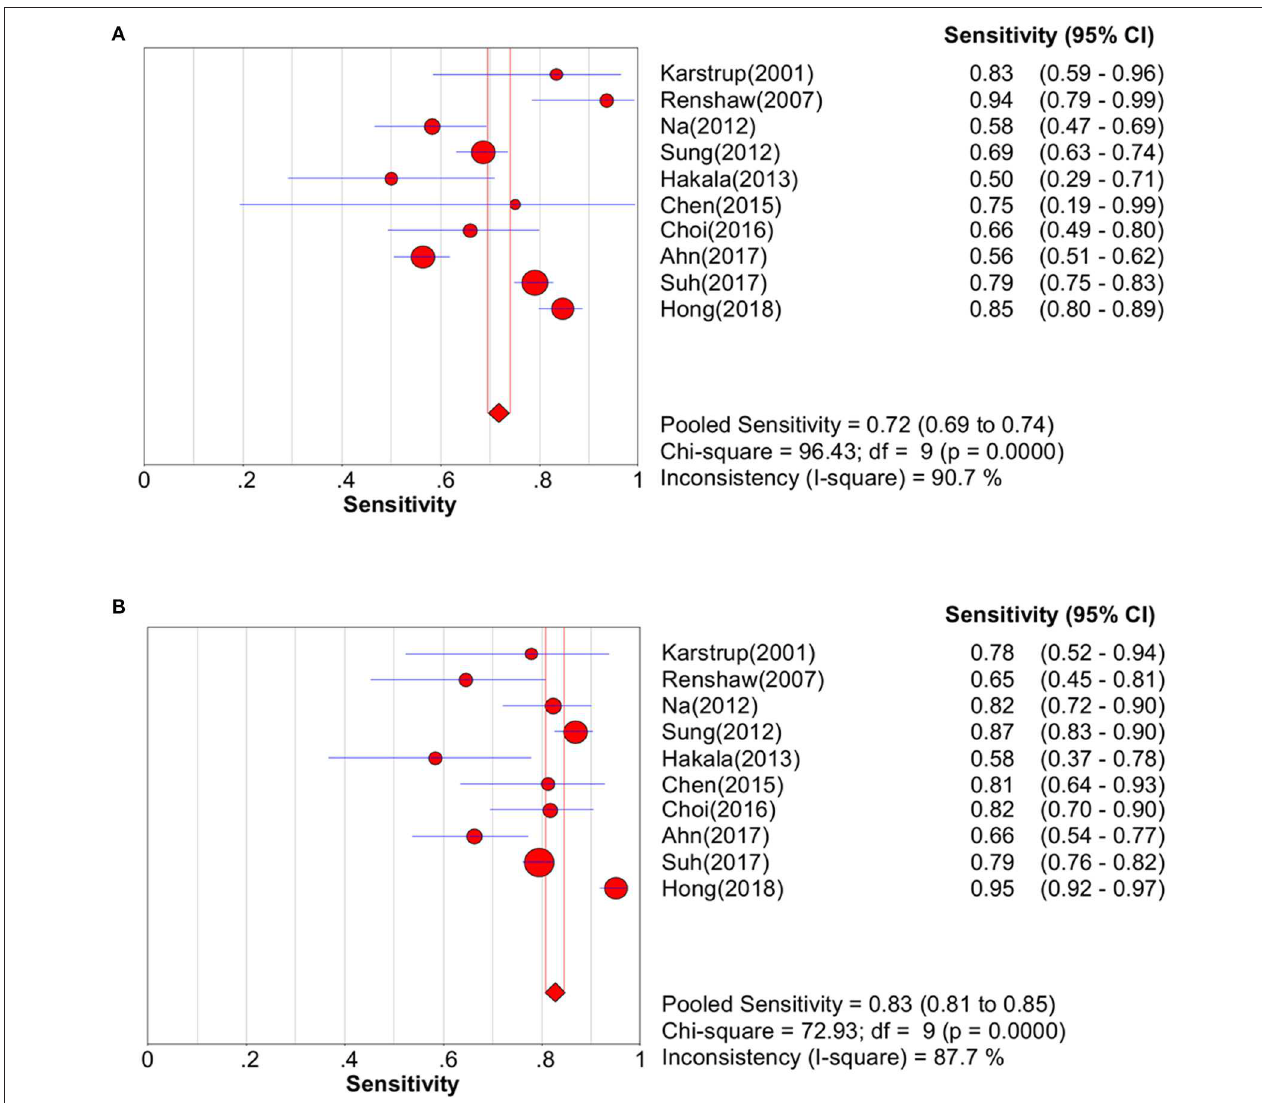
FIGURE 3 | Pooled sensitivity forest plot of two methods in diagnosing thyroid cancer. (A) FNA; (B)